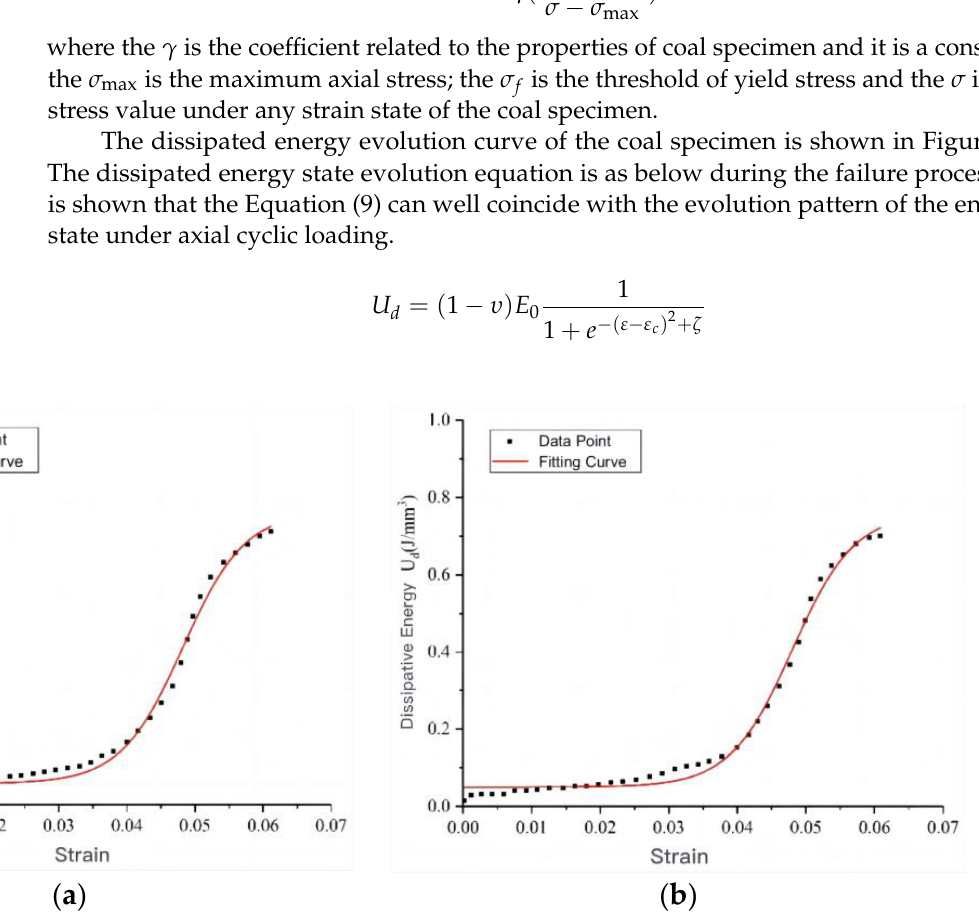
Figure 12. Trend diagram of coal specimen dissipation energy under axial cyclic loading. ( a ) The dissipated energy evolution curve of the coal sample S1. ( b ) The dissipated energy evolution curve of the coal sample